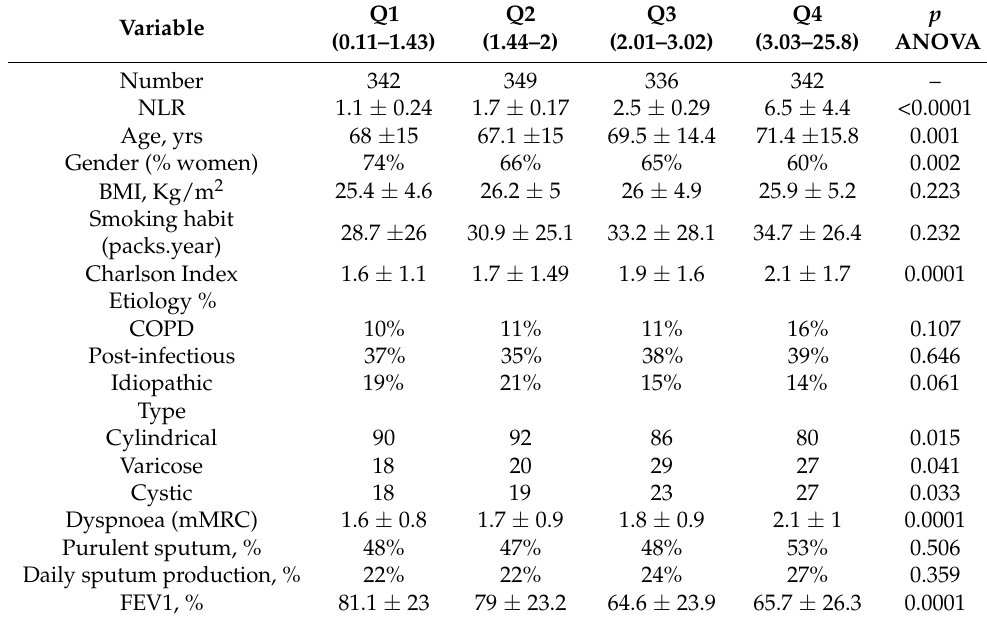
Table 1. Differentiating characteristics of the quartiles of the neutrophil-to-lymphocyte ratio.